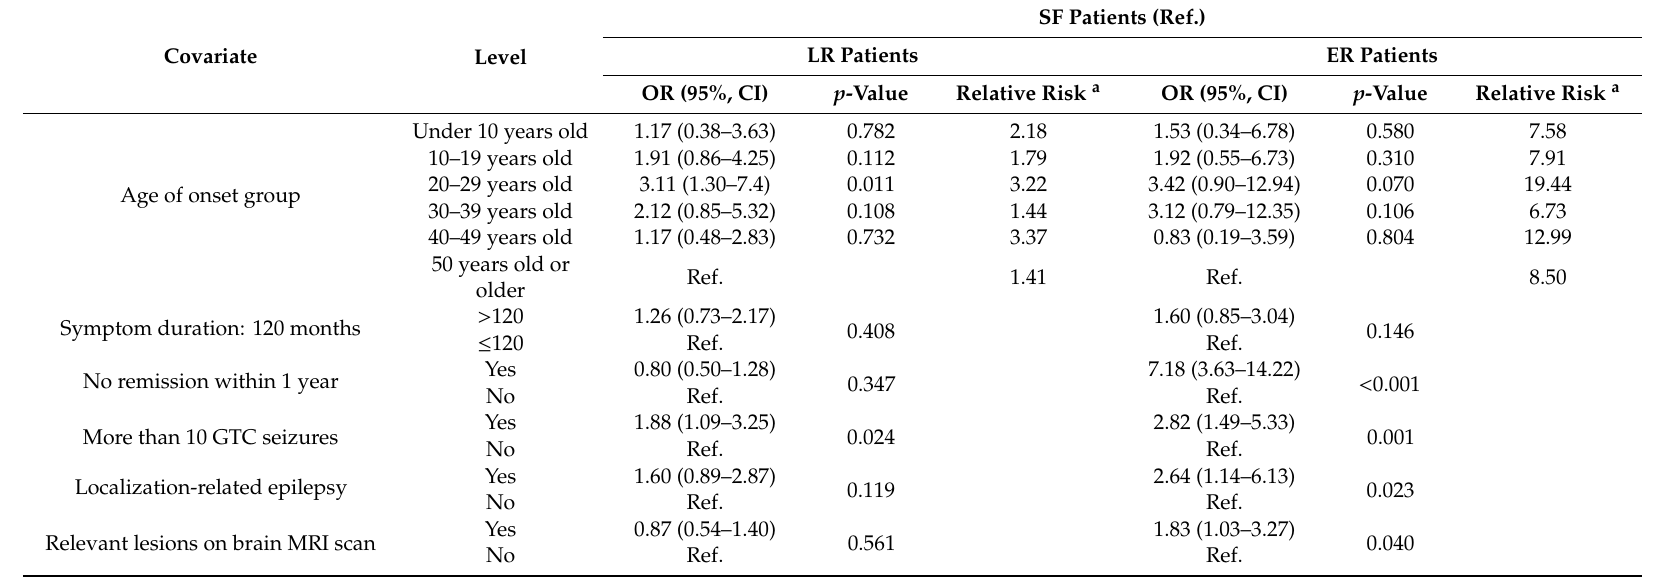
Table 4. Prognostic multivariable multinomial analysis in relapsed patients with SF patients as the